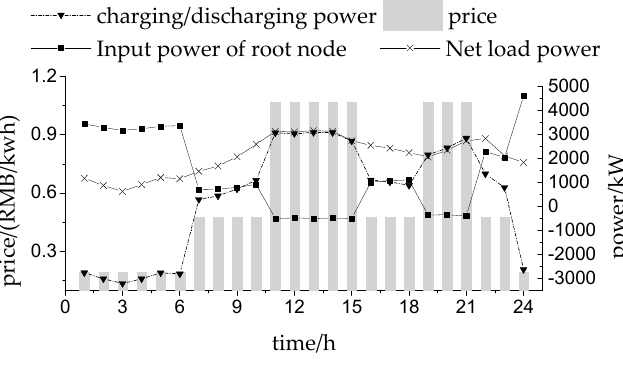
Figure 9. The curves of the ESS charge power and the power supplied by the distribution network.